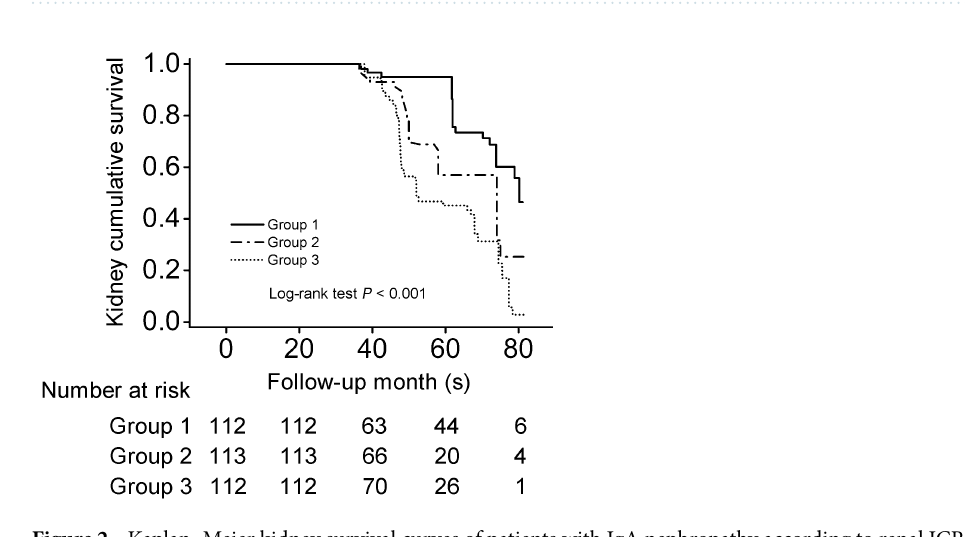
Figure 2. Kaplan–Meier kidney survival curves of patients with IgA nephropathy according to renal ICR tertiles. IgA nephropathy patients were stratified into three groups based on the tertiles of renal ICR levels: group 1 (< 1.56), group 2 (1.56–3.04), and group 3 (>